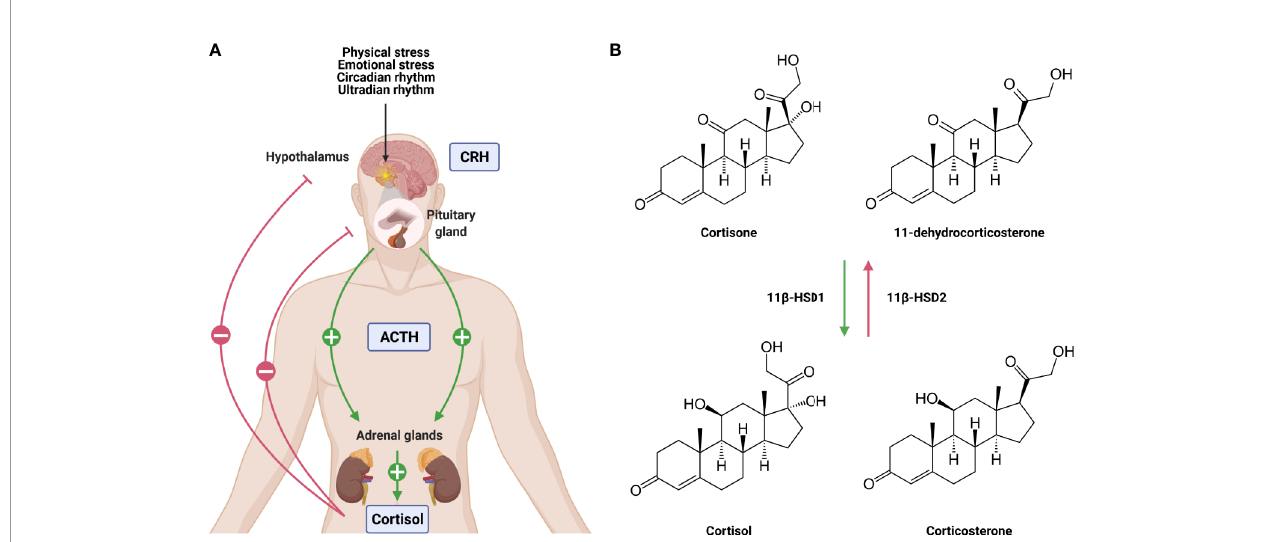
FIGURE 1 | The hypothalamic-pituitary-adrenal (HPA) axis (A) and the conversion of glucocorticoids (GCs) (B) . (A) Under unstressed, homeostatic conditions GCs are released from the adrenal glands in the blood stream in a circadian and ultradian rhythm. Upon physiological and emotional stress, this release is increased. Stimulation of the HPA axis induces the secretion of corticotrophin releasing hormone (CRH) by the hypothalamus which stimulates the release of adrenocorticotrophic hormone (ACTH) by the pituitary. This will lead to the production of GCs by the adrenal glands and the secretion into the blood stream. Blood GC levels regulate the hypothalamus and the pituitary via a negative feedback loop. (B) The lipophilic GCs diffuse freely through the plasma membrane. The bioavailability of the GCs is regulated by 11 b -HSD1 and 11 b -HSD2 which are responsible for the conversion of inactive cortisone/11-dehydrocortisone into active cortisol/corticosterone and vice versa . Figures created with